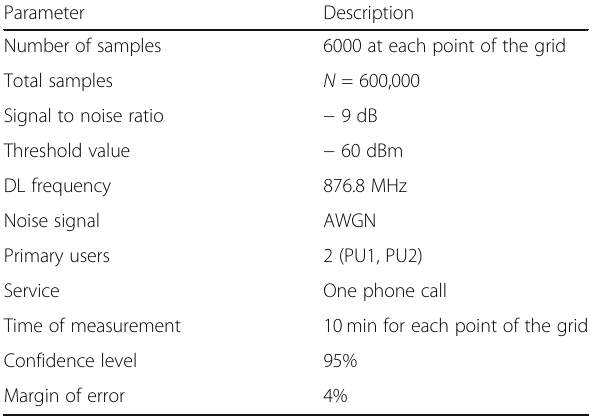
Table 3 Parameters for energy detection